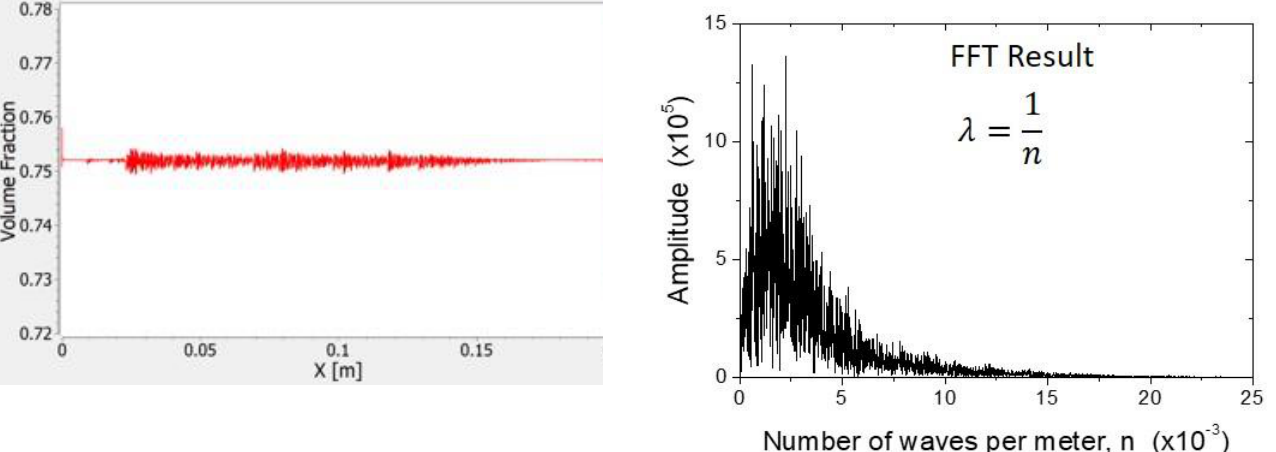
Figure 8. Fastest growing wavelength v.s. time ( left ) and corresponding contour of volume fraction ( right ) in Kelvin – Helmholtz instability (ΔV = 4 m/s); the contour size is 3.0 mm vertically and 6.2 mm horizontally. These correspond to 150 vertical and 310 horizontal mesh elements.